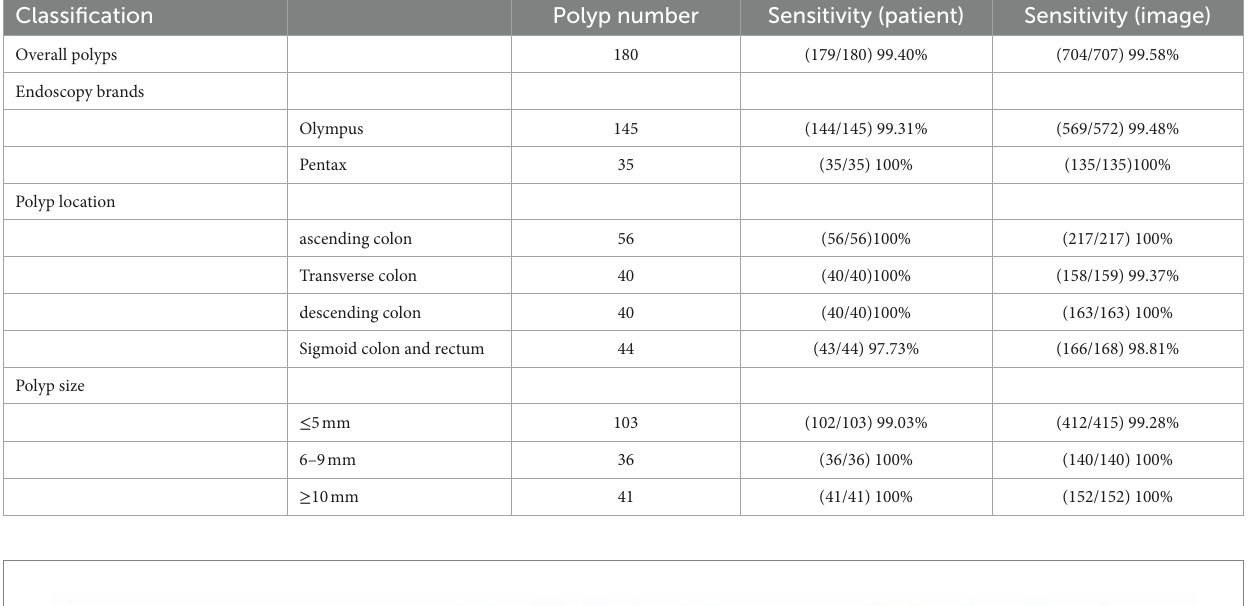
TABLE 3 Sensitivity of polyp recognition and subgroup analysis.